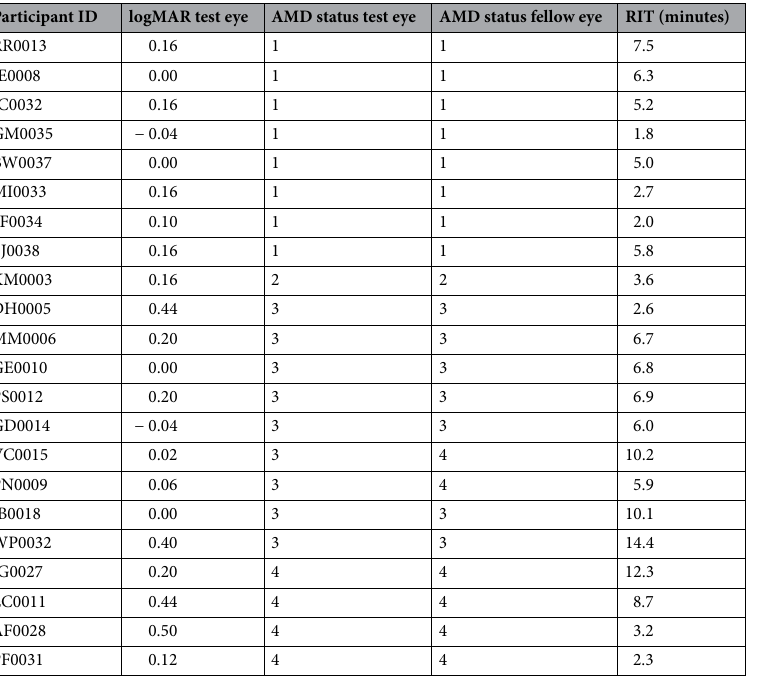
Table 1. Clinical characteristics of all participants. AMD graded according to the Beckman initiative severity scale. In short, eyes were grouped as normal ageing [1], early AMD [2], intermediate AMD [3], and late AMD [4] (geographical atrophy and/or neovascular lesions) 33